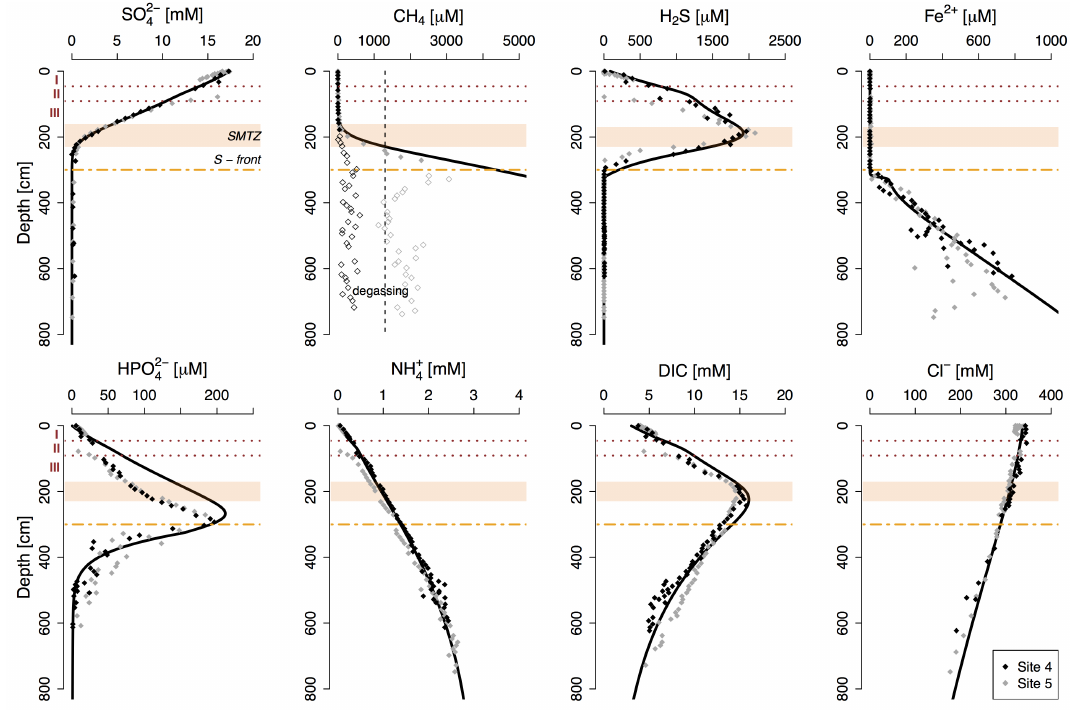
Figure 3. Porewater profiles of key components for site 4 (black diamonds) and site 5 (gray diamonds) and corresponding modeled profiles as calculated with the diagenetic model (black lines). Red dotted lines and roman numbers indicate the transitions between the lithological Unit I (modern coccolith ooze), Unit II (marine sapropel) and Unit III (limnic deposits). The orange bar represents the sulfate-methane transition zone (SMTZ), and the orange dashed line shows the current position of the downward-migrating sulfidization front (S front). The dashed vertical line indicates the CH 4 saturation concentration at atmospheric pressure (Mogollón et al., 2013). The open diamonds indicate CH 4 concentrations that are likely underestimated due to outgassing of CH 4 during coring.